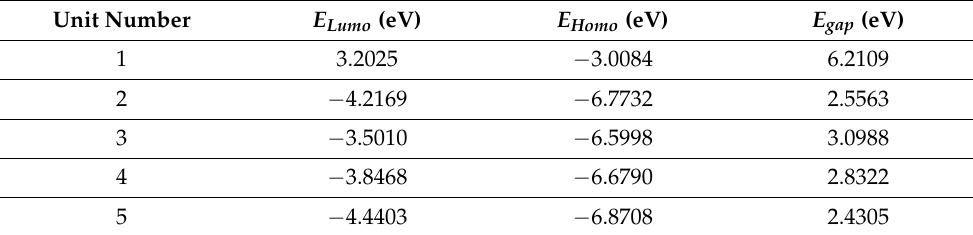
Table 4. Quantum chemical parameters calculated for the different forms of monomer. Unit Number